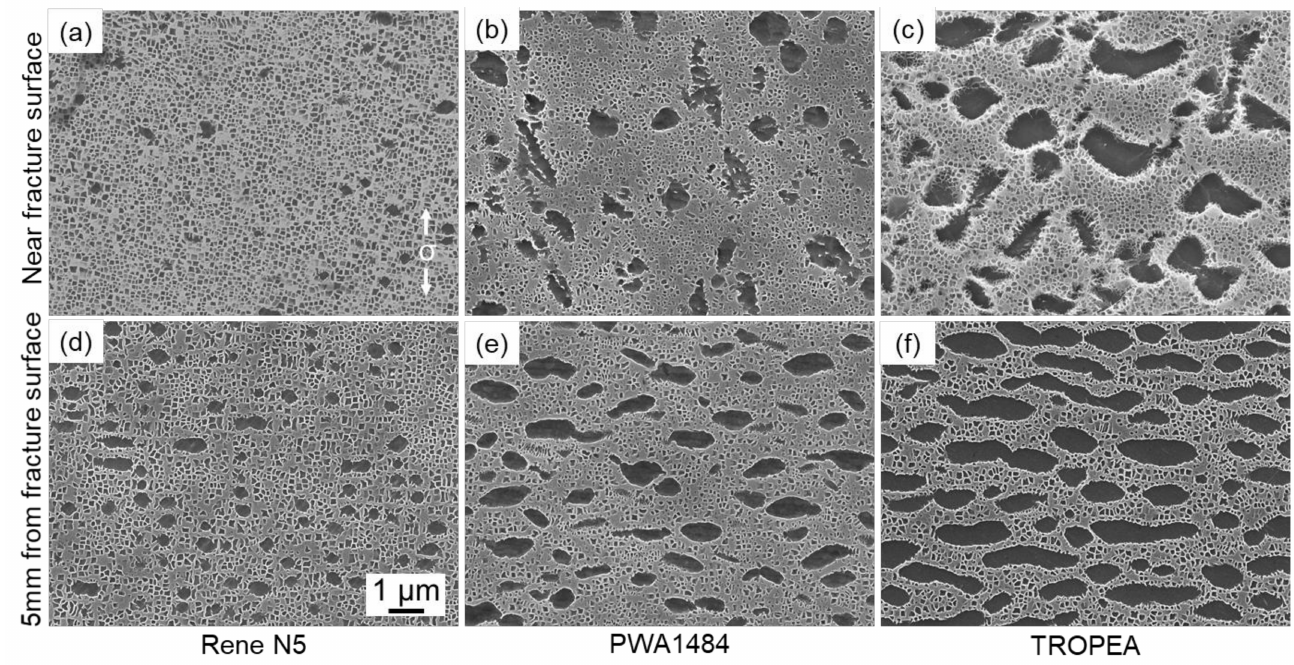
Figure 8. Microstructures after creep rupture tests at 1250 ◦ C/60 MPa. ( a , d ) Rene N5, ( b , d ) PWA1484, and ( c , f ) TROPEA. ( a – c ) Near fracture surface and ( d – f ) 5 mm from the fracture surface.